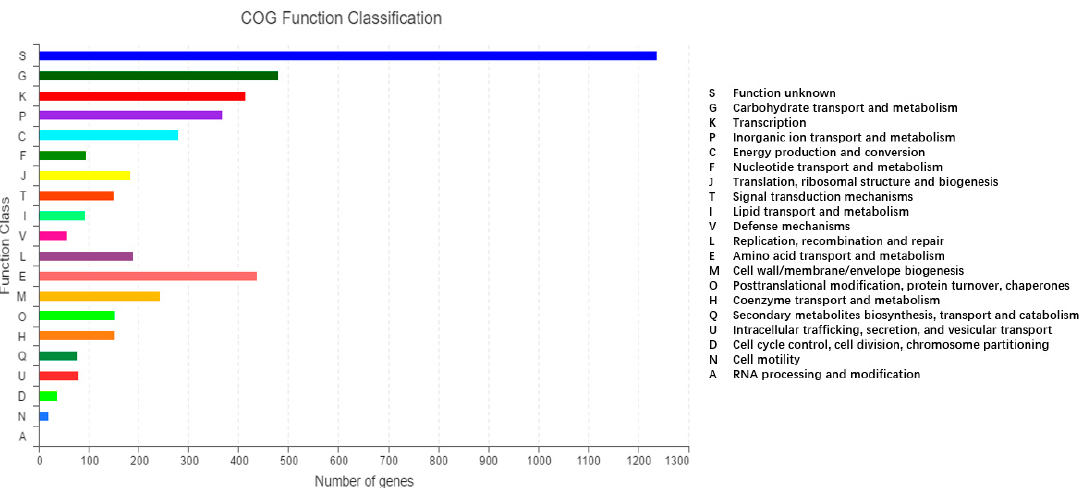
Figure 3. Functional classifications of genes from K. pneumoniae 2N3 based on the Clusters of Orthologous Groups (COG) proteins database.